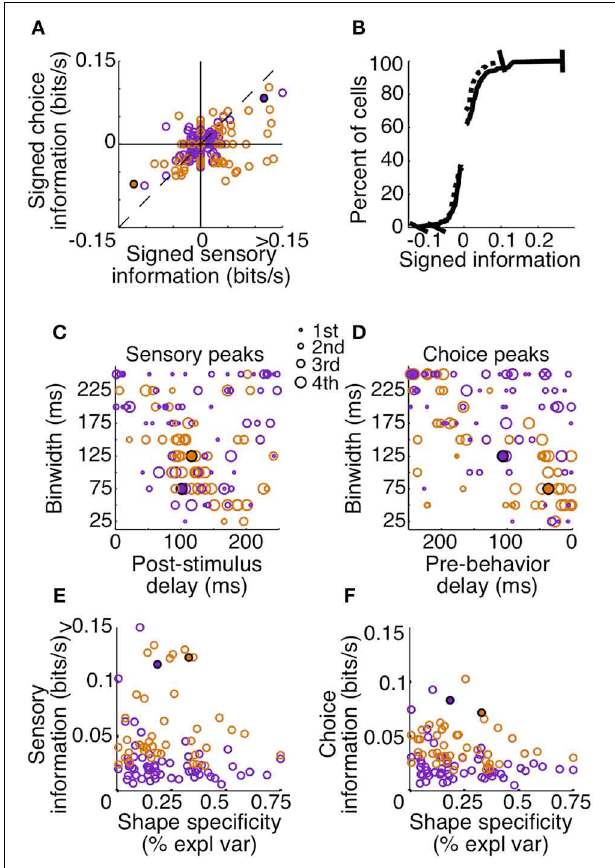
FIGURE 7 | Sensory and choice information for individual units. Plots depict signed sensory information (A,B) , peak delay and resolutions (C,D) , and the relationship between reliability and shape specificity (E,F) . Points are colored by animal (Z: purple, J: orange), and filled circles indicate two of the example cells from Figures 3 , 6 . The third example cell lies at the origin in (A) and is absent from (B–F) because the number of significant points did not exceed the false alarm criteria on either surface. Many neurons in area V4 reflected both which stimulus was present, as well as the animal’s subsequent behavior. Cells in quadrant 1 of (A) had significant sensory and choice modulation resulting from increased activity, while cells in quadrant 3 of (A) had significant sensory and choice information resulting from decreases in activity. The thin dotted line in (A) represents unity. In (B–F) , only units with significant sensory and choice information are shown ( N = 99). Distributions from (A) were plotted cumulatively in ( B , sensory: solid line, choice: dotted line). In (C,D) , circle size represents the quartile containing the unit’s information, with the largest circles being the most informative